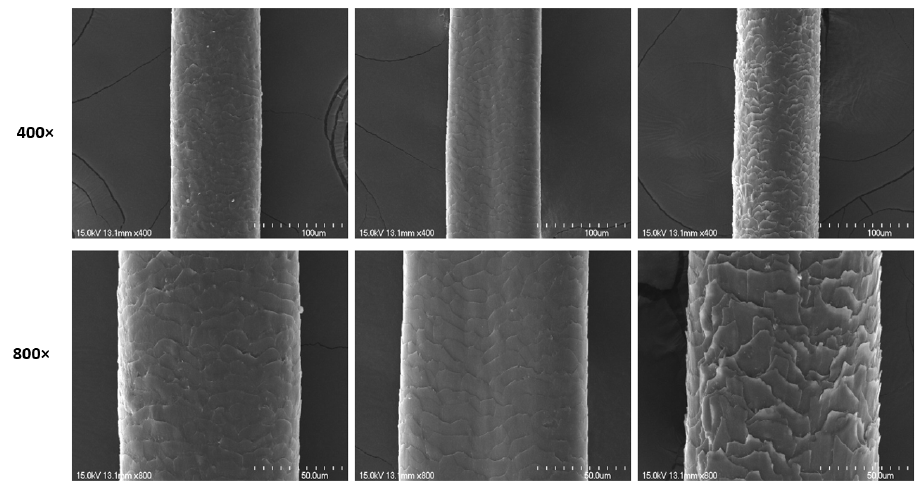
Figure 10. Comparison of hair’s microscopic details under different magnifications.